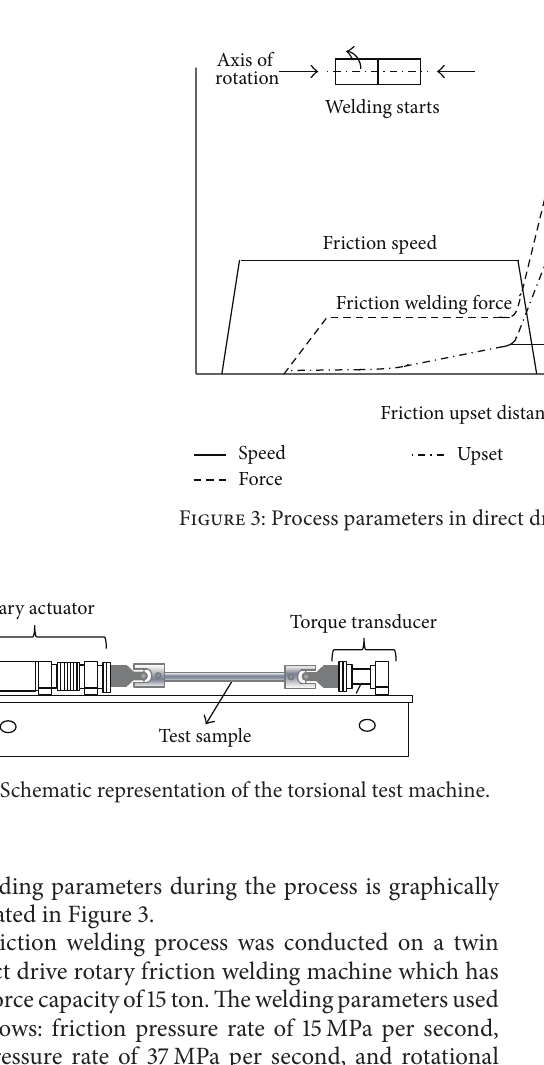
Figure 5: Friction welded joint.